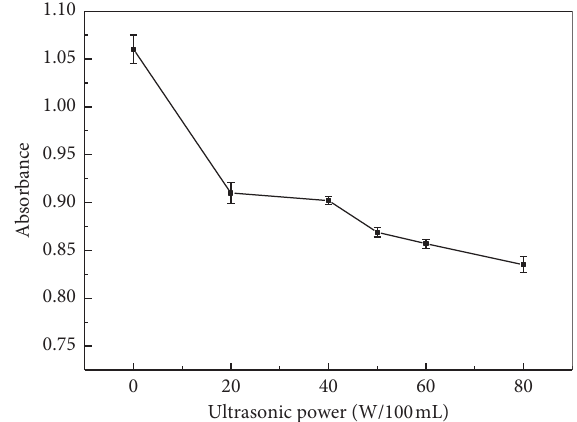
Figure 3: The maximum absorption intensity (664nm) of the methylene blue solution in the UV-visible light varies with the ultrasonic time.